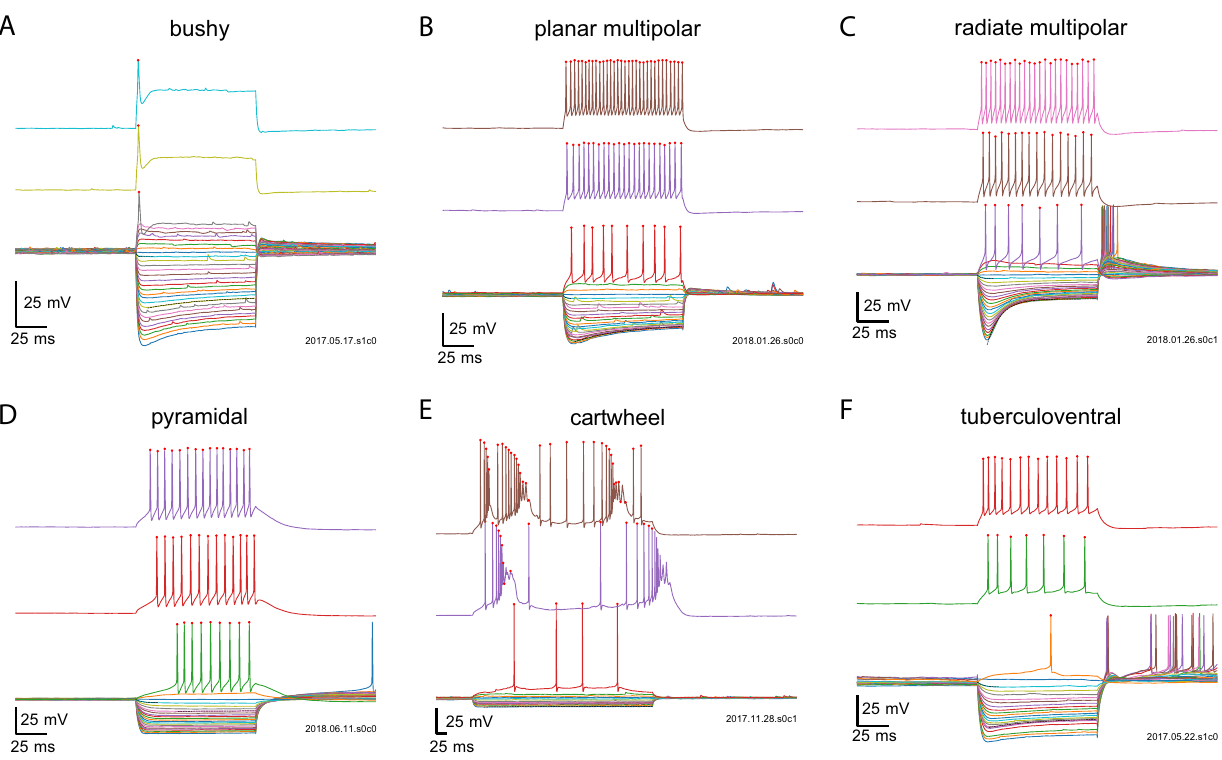
Fig 1. Examples of discharge patterns and passive responses, for different levels of current injection for 6 classes of cochlear nucleus neurons. A. Bushy; B. planar multipolar; C. radiate multipolar; D. pyramidal; E. cartwheel; F. tuberculoventral. Red dots indicate spikes evoked by current injection.